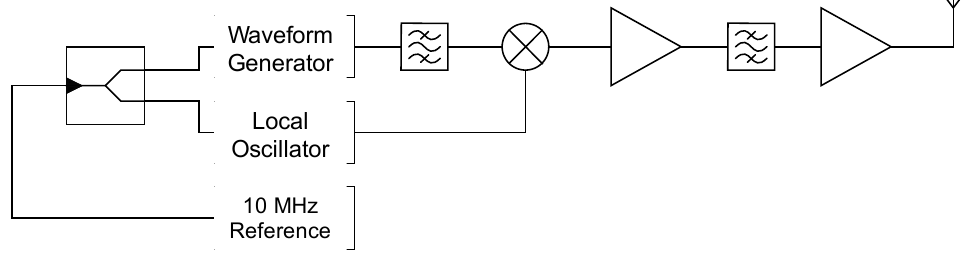
Figure 3. The structural schematic of the X-band transmitter used as illuminator for the bistatic radar